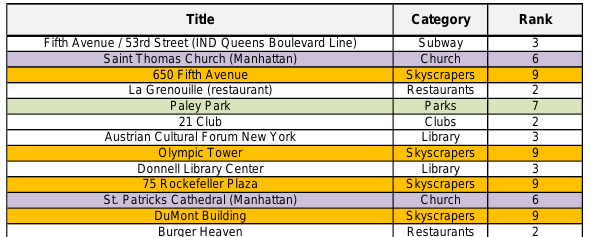
Table 4. 13 Wikipedia entries (landmarks) with ranking scores for point P3 after the initial filtering